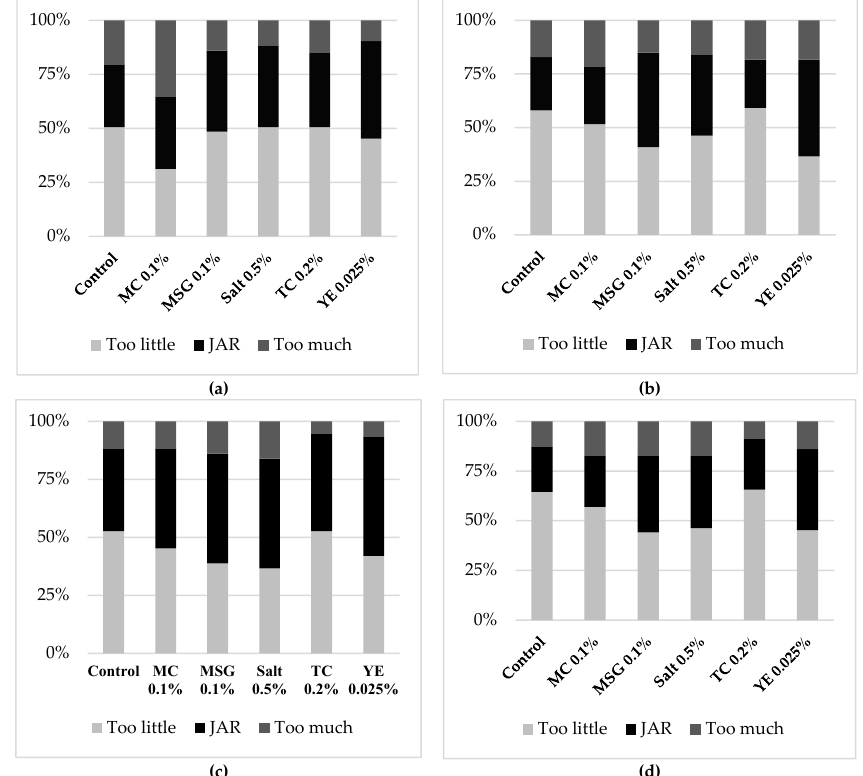
Figure 2. Distribution of consumer JAR scores for sensory attributes of chicken soups: ( a ) Color; ( b ) Overall flavor; ( c ) Salty taste; ( d ) Savory taste.